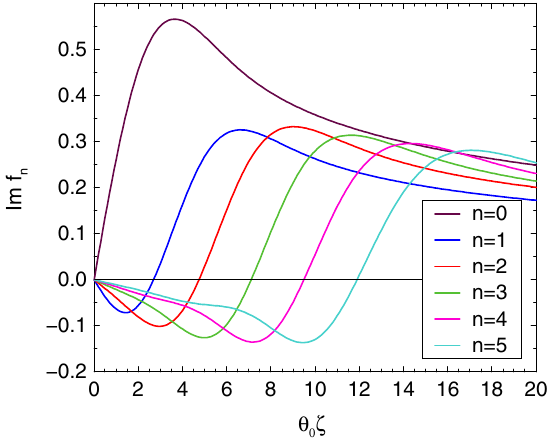
FIG. 10. Imaginary parts of the functions f Gaussian bunch are plotted likewise in Fig. 4. They represent the effect of the intrabunch interaction on the instability growth rate. The right-hand parts of these odd functions are shown.